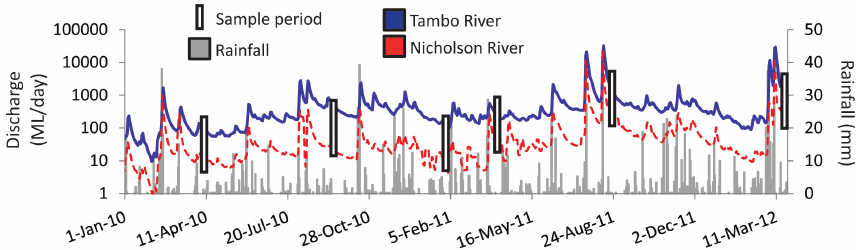
Fig. 2. Sampling frequency superimposed on river hydrographs (Tambo River=Battens Landing station 223209, Nicholson River=Sarsfield gauging station 223210) and rainfall in the Tambo Catchment (Bairnsdale Airport, station